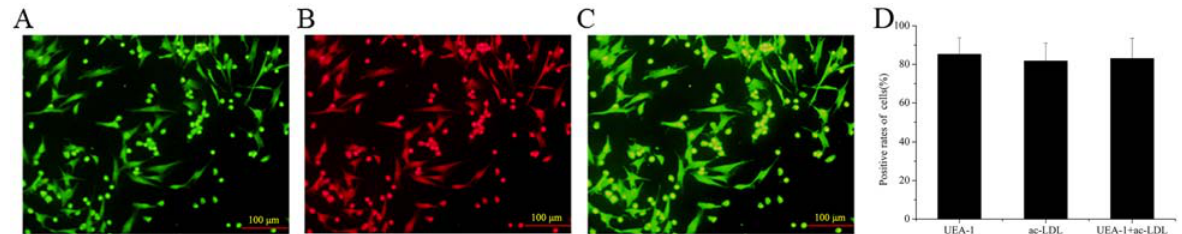
Figure 2. Endothelial progenitor cells were detected by immuno fl uorescence after co-culture with Dil-acetylated-low-density lipoprotein (Dil-ac-LDL) and FITC- Ulex europaeus agglutinin-1 (UEA-1). A , Cell binding with FITC-UEA-1 is shown as green. B , Cells that take up Dil-ac-LDL are shown as red. C , Cells with positive FITC-UEA-1 and Dil-ac-LDL staining (scale bar 100 m m). D , Bar graph of panels A, B, and C. Data are reported as means ±